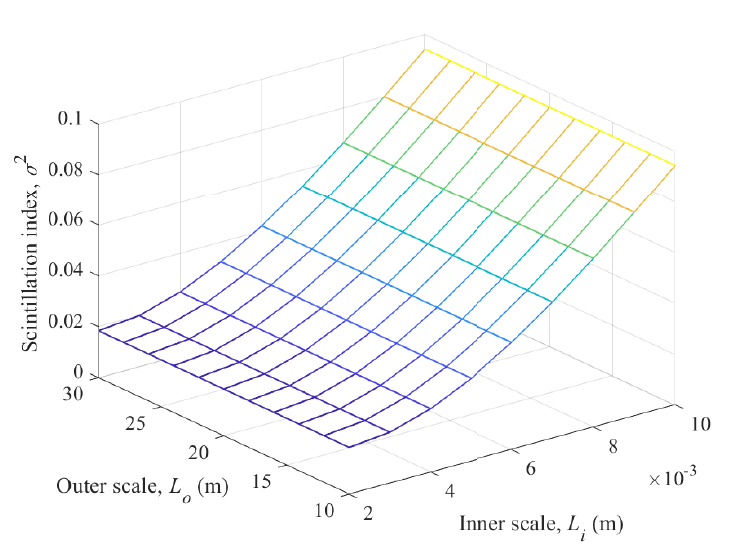
Figure 11. Scintillation index of a spherical wave versus the inner and outer scales. The turbulence structure parameter is an influencing factor that affects the intensity of turbulence. Figure 12 analyzes the influence of the turbulence structure parameters, C 2 , on the scintillation index with aperture averaging of a spherical wave in the marine n environment. The results show that the scintillation index increases with the increase of C 2 This phenomenon is more obvious with the increase of the communication